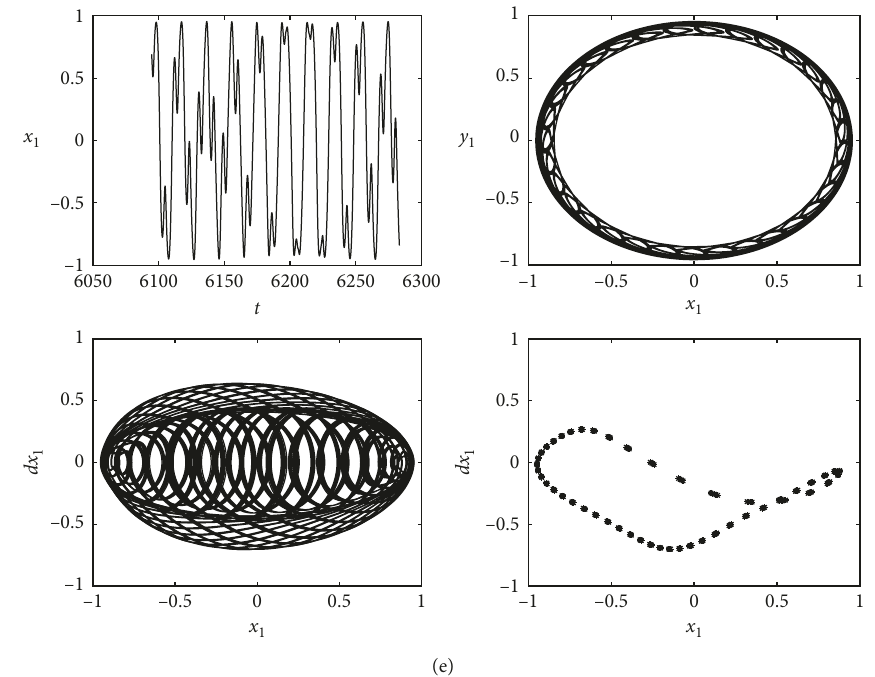
Figure 12: Response oftherotor systemat differentrotation speedswhen k (d) ω � 1875rad/s, and (e) ω � 2500rad/s.